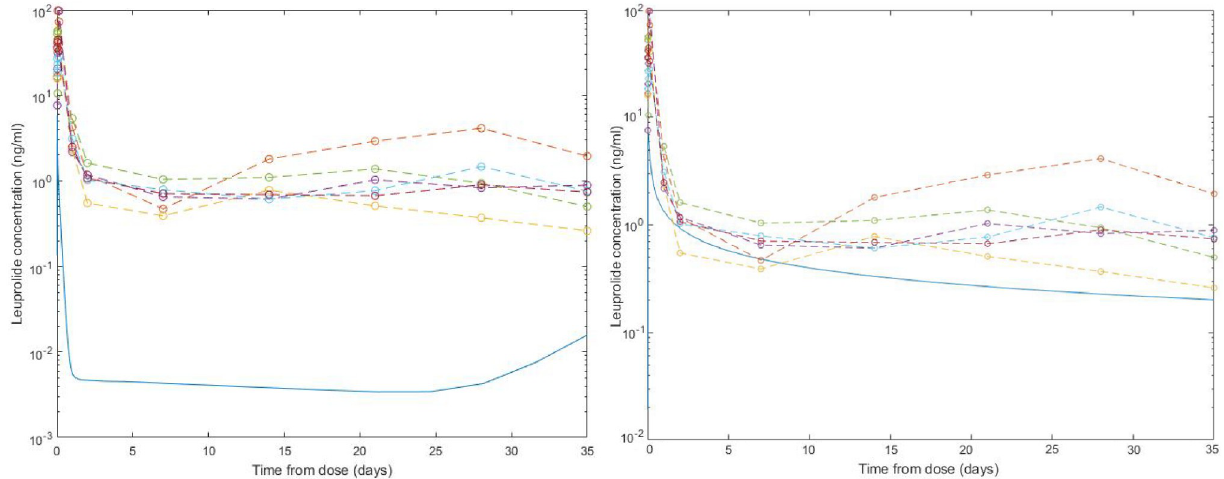
Fig 4. Comparison between the fits obtained for the drug concentration proposed on the basis of mass action law (left) and diffusion-based model (right). Various colors reflect mean population levels for several different Lupron depots available from FDA label.